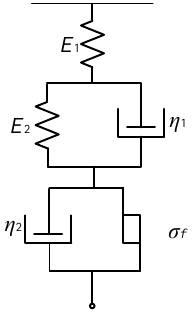
Figure 9. The Schofield–Scott Blair constitutive model.